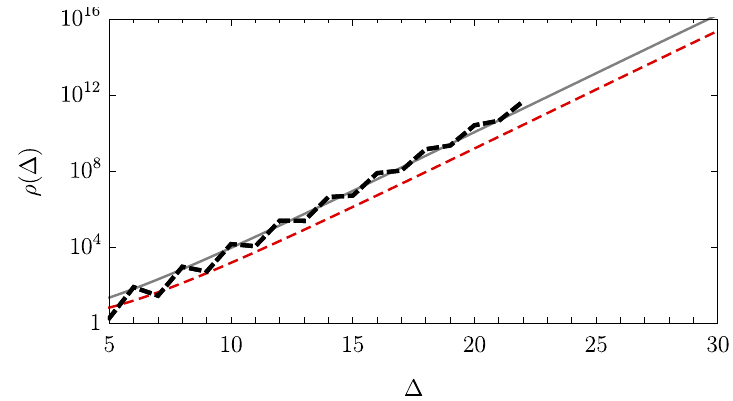
Figure 4: The effect of a linear shift in ∆ to capture sub-leading corrections to the asymptotic formula for the growth of operators in the SMEFT, with one generation of = 1. The thick dashed line is the exact results for the number of opera- fermions, N g tors in the SMEFT as a function of ∆ . The thin dashed curve indicates the asymptotic result given in Eq. (145). The solid grey curve indicates Eq. (145) evaluated with the shifted (cid:101) ∆ given by Eq.